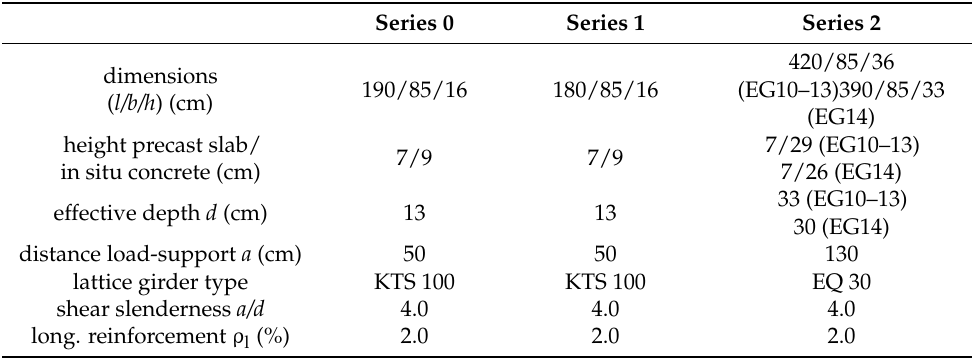
Table 3. Dimensions and geometrical parameters of test